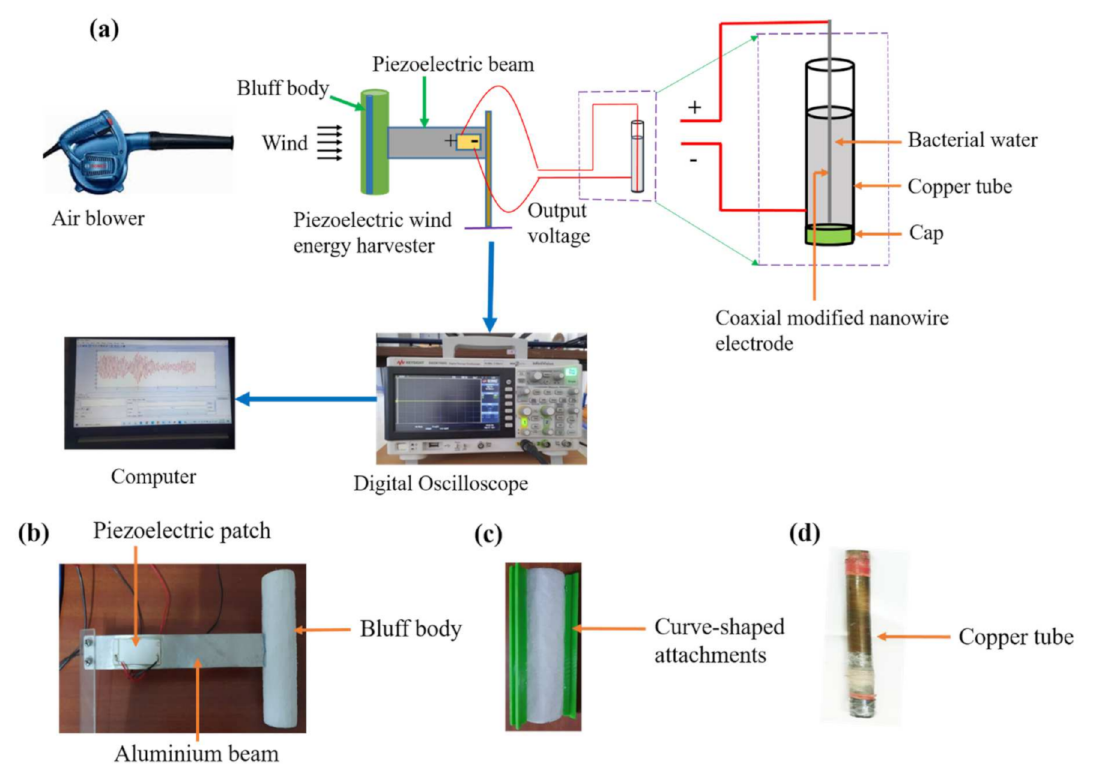
Figure 3. Experimental setup: ( a ) bacterial disinfection using a galloping piezoelectric wind energy harvester; ( b ) piezoelectric wind energy harvester; ( c ) bluff body with curve-shaped attachments and ( d ) copper